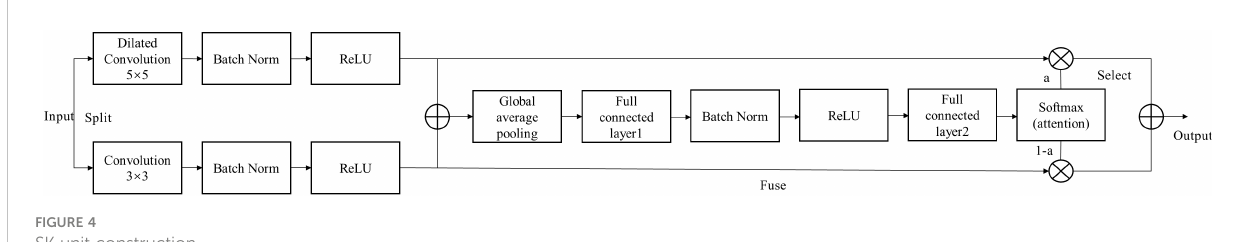
FIGURE 4 SK unit